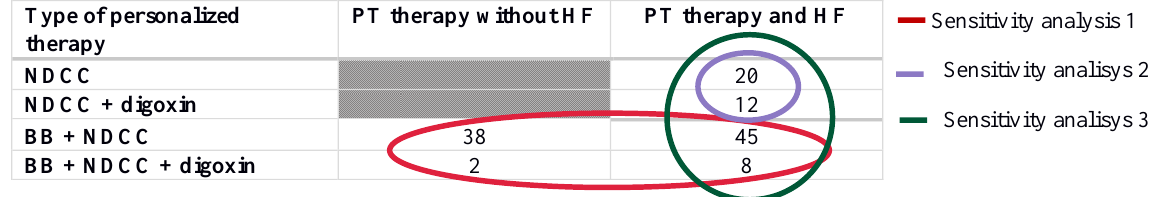
ACE (angiotensin-converting enzyme), BB (beta-blockers), BMI (body mass index), CAD (coronary artery disease), COPD (chronic obstructive pulmonary disease), DOAC (direct oral anticoagulant), NDCC (non-dihydropyridine calcium channel blockers), NYHA (New York Heart Association), TIA (transient ischemic attack).